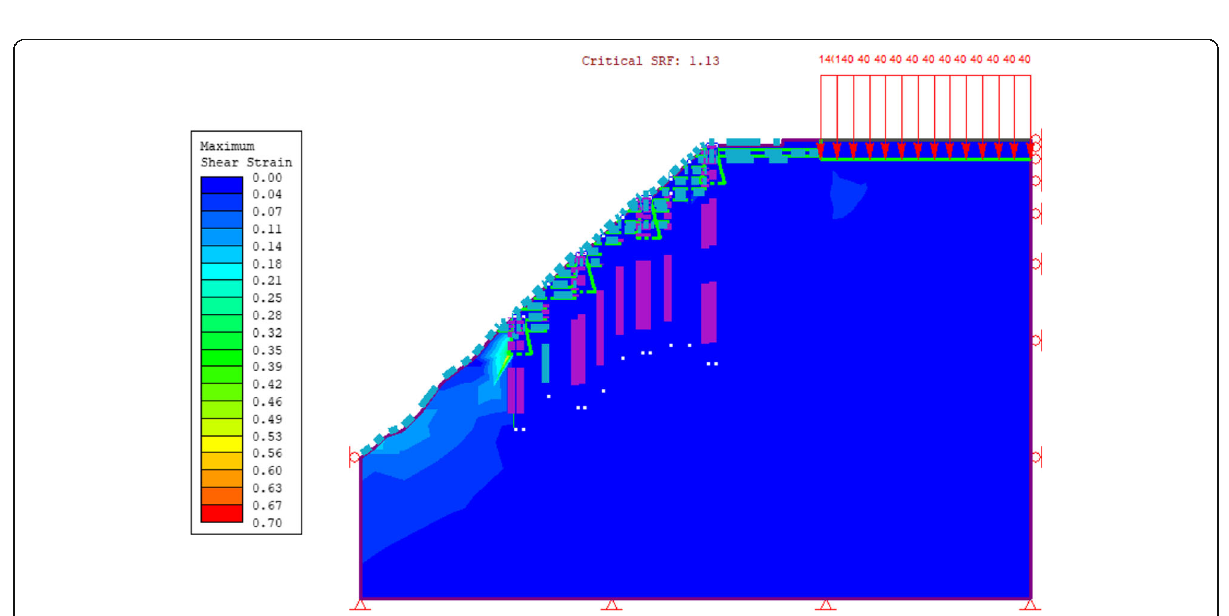
Fig. 13 Maximum shear strain for reinforced slope with micropile, geocell and geogrid